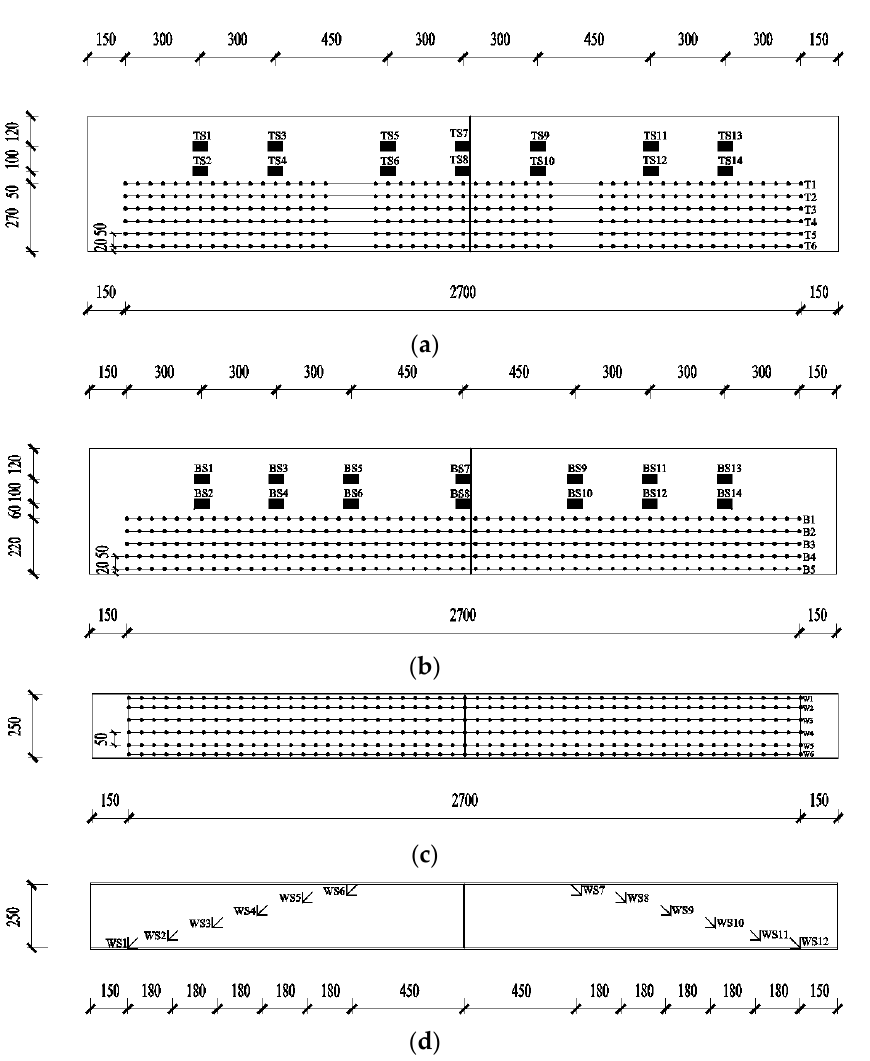
Figure 4. Layout diagram of inspection lines and strain gauges/unit: mm. ( a ) Top flange; ( b ) bottom flange; ( c ) one side of the web where the inspection lines were arranged; ( d ) one side of the web where the strain rosettes were arranged.